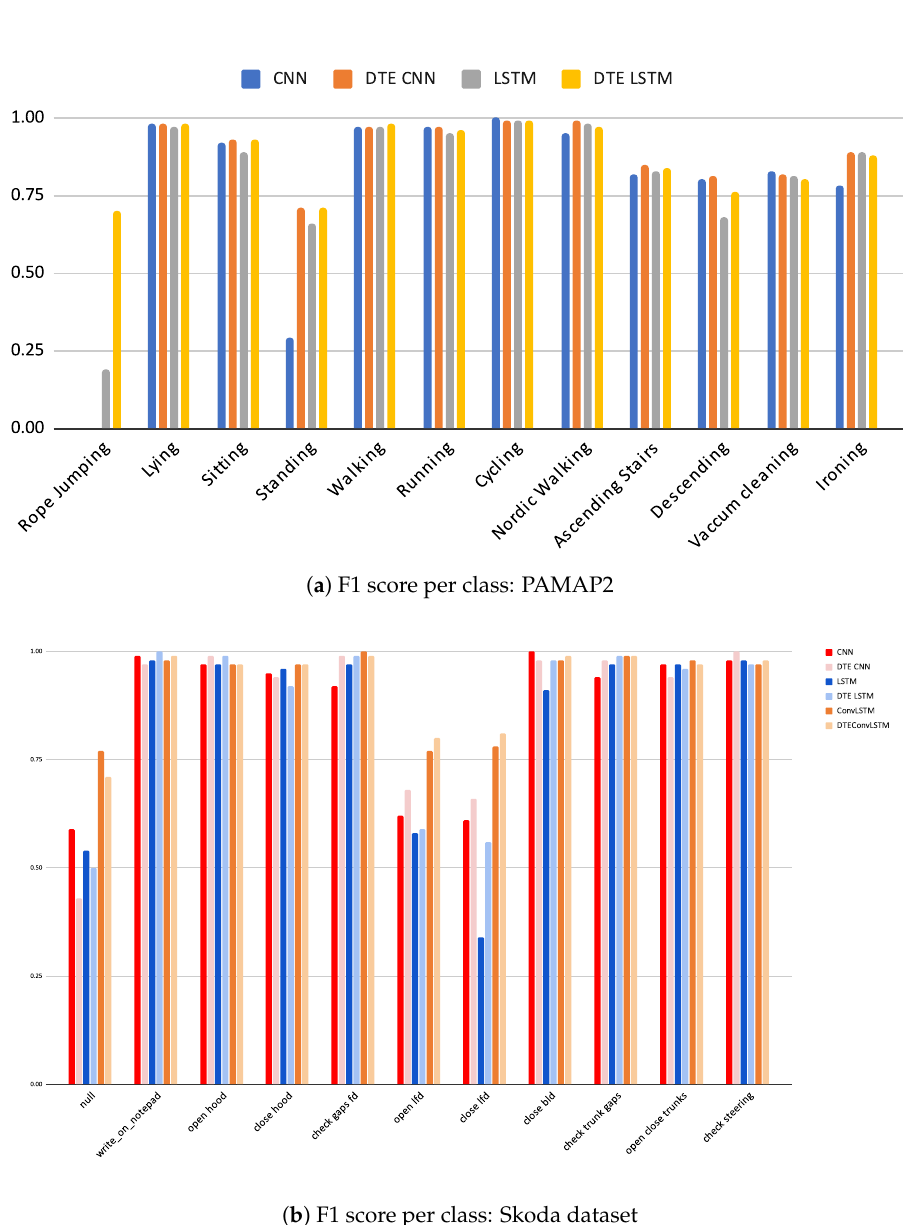
Figure 8. F1 scores per class for PAMAP2 and Skoda